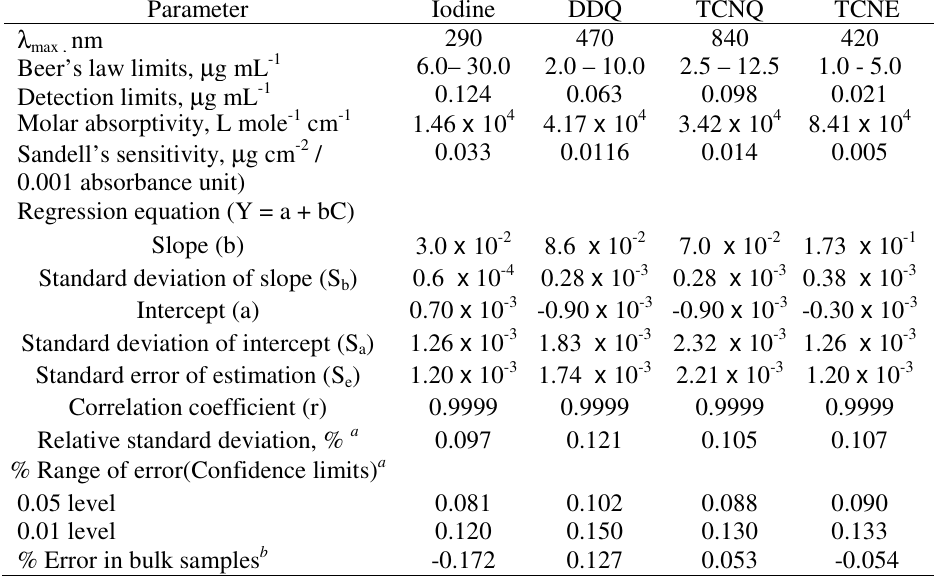
Table 2. Optical, regression characteristics of the proposed methods for